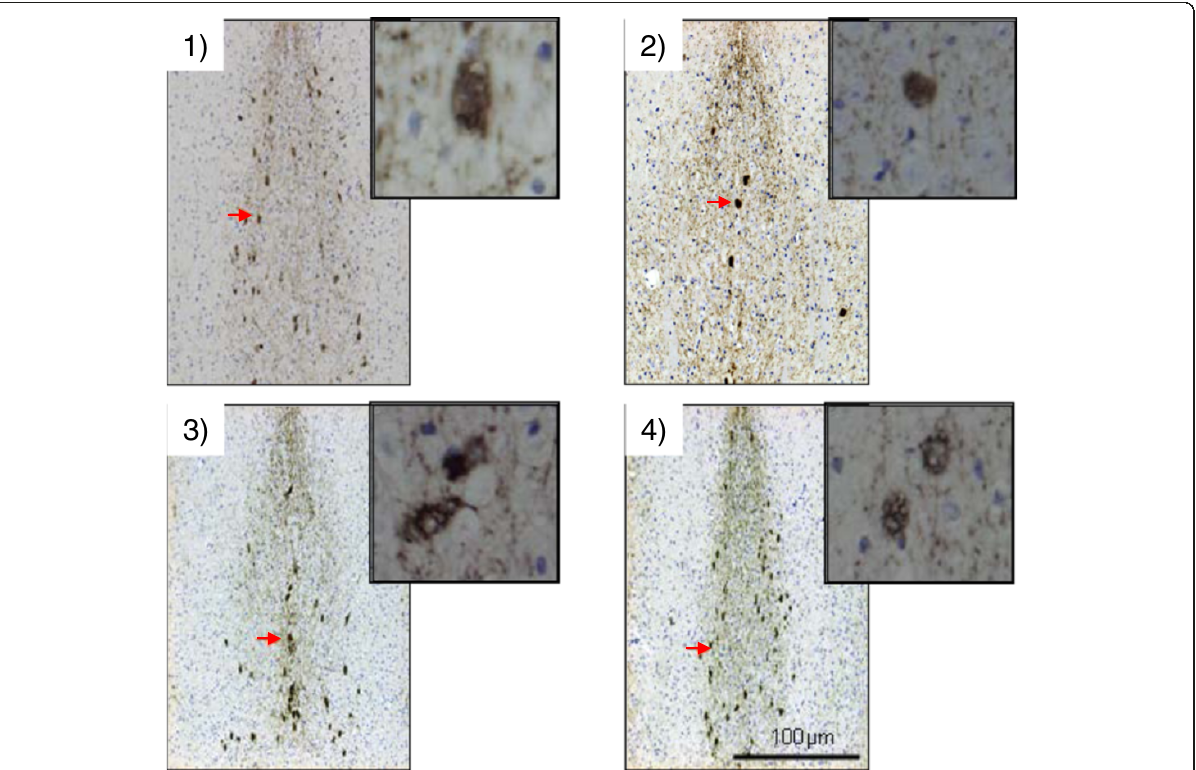
Figure 10 Effects of CTS and THA treatment on diabetes-induced cholinergic neuron degeneration in the medial septum. Cholinergic neurons were identified by ChAT immunostaining in vehicle-treated m/m (1), and vehicle (2)-, CTS (750 mg/kg per day: 3)-, and THA (2.5 mg/kg per day; 4)-treated db/db mice. Cholinergic neurons were stained with anti-ChAT antibody, showing that predominant ChAT expression occurred in the cell body of cholinergic neurons. Scale bar = 100 μ